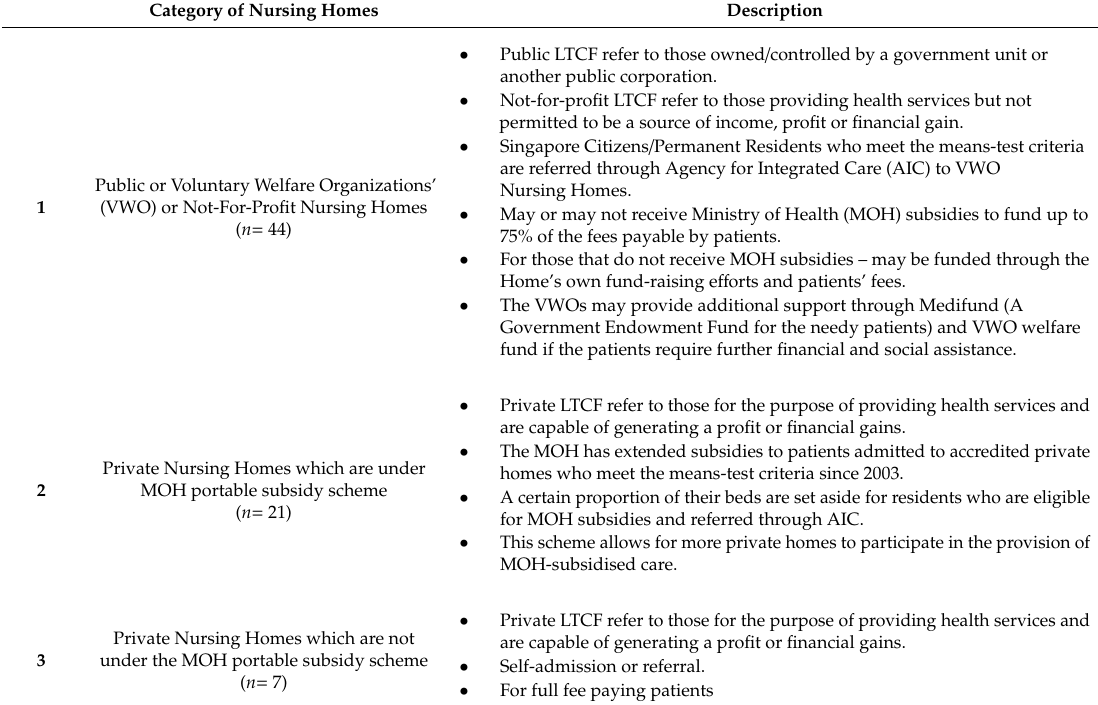
Table A1. Description of LTCFs in Singapore (based on 2018 data from https: // www.moh.gov.sg / resources-statistics / singapore-health-facts /